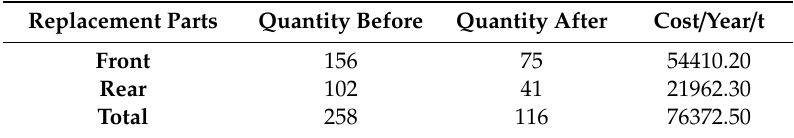
Table 7. Comparative table of the number of